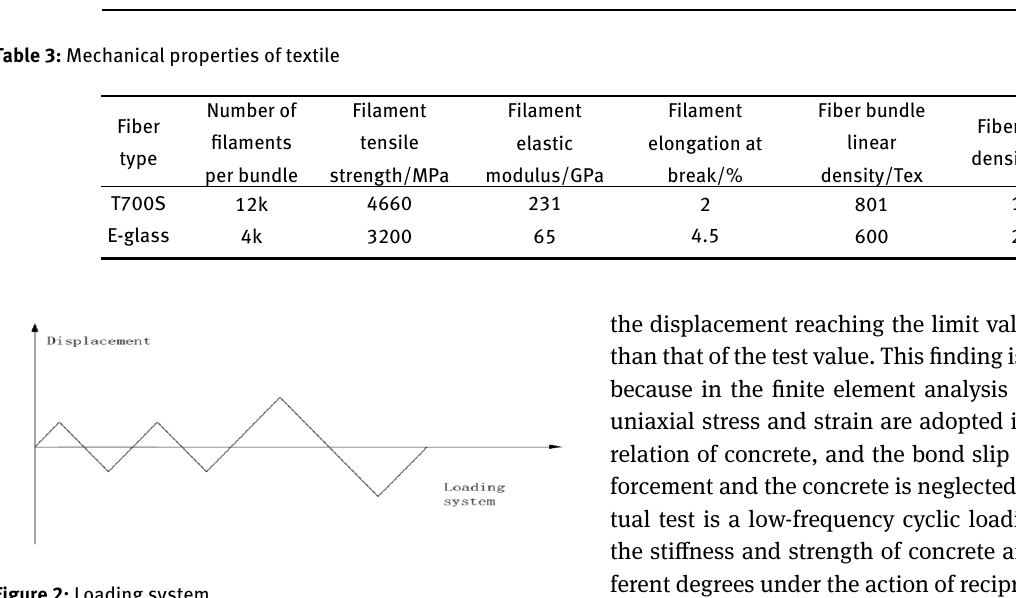
Figure 2: Loading